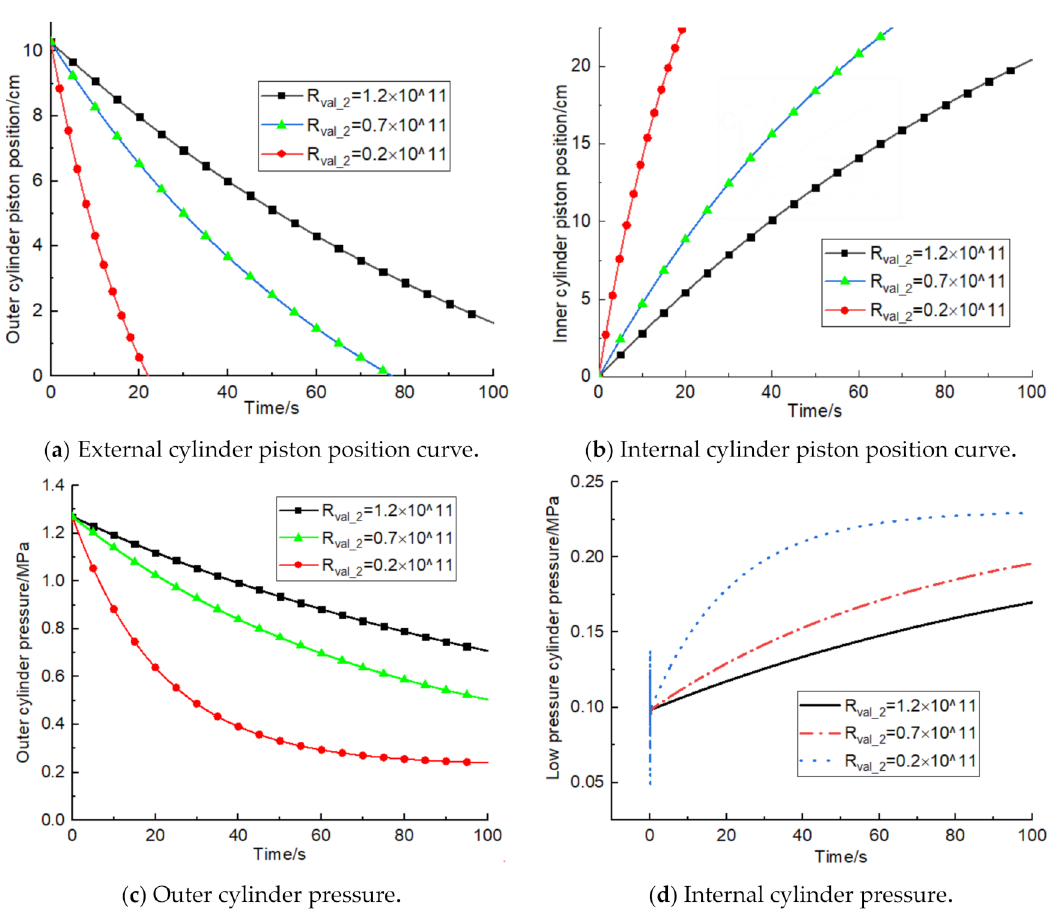
Figure 5. Hydraulic system status curve during submersible